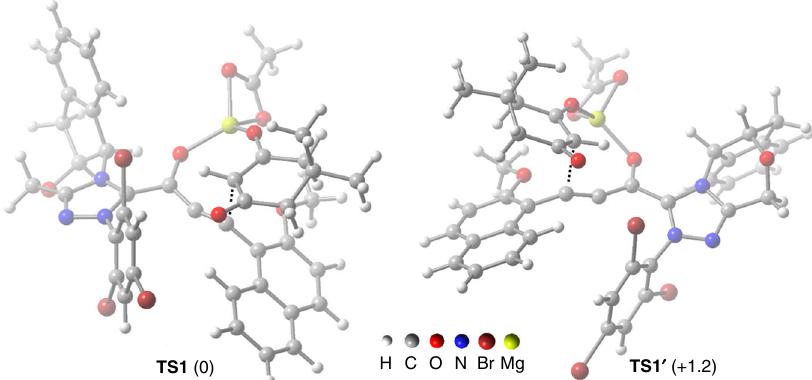
TS1 (0) Fig. 8 Comparison of transition states. Relative free energy (kcal mol − 1 ) of TS1 and TS1' are displayed in the